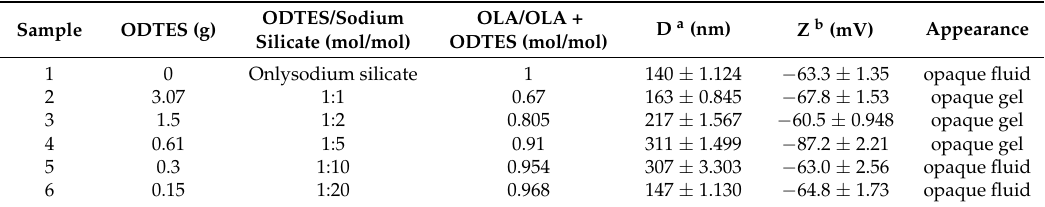
Table 1. Compositions of the investigated silica hybrids.